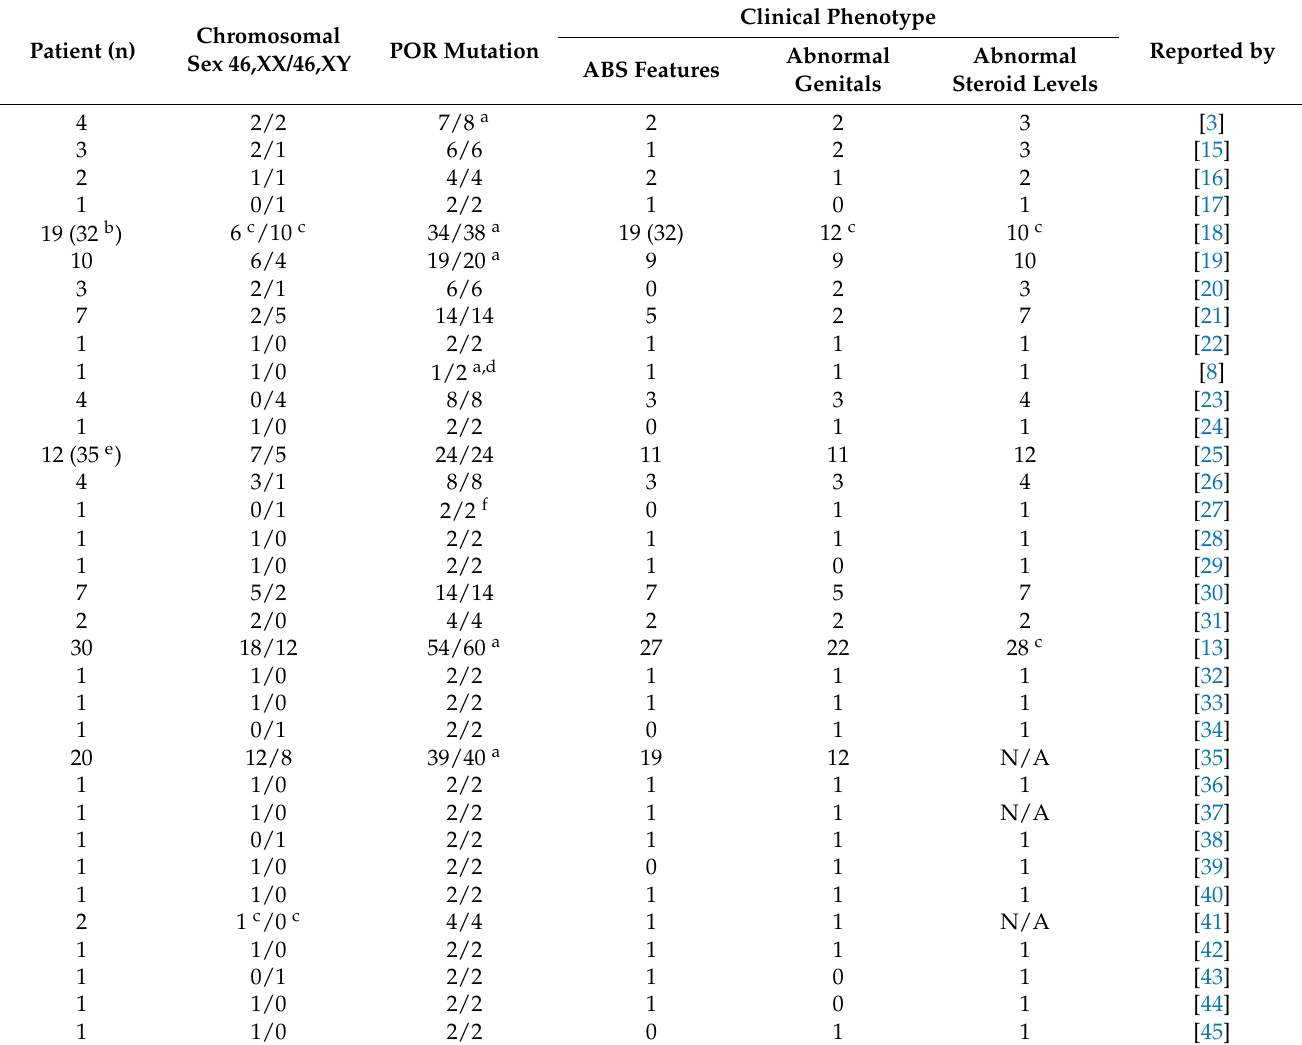
Table 1. Reported cases of POR